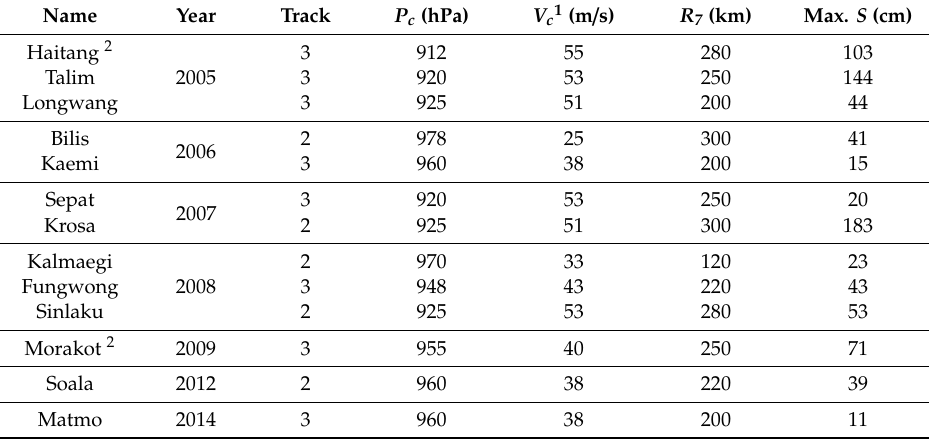
Table 1. Central pressure ( P c ), maximum wind speed ( V c ), and radius ( R 7 ) of typhoons as well as Max. surge ( S ) in historical